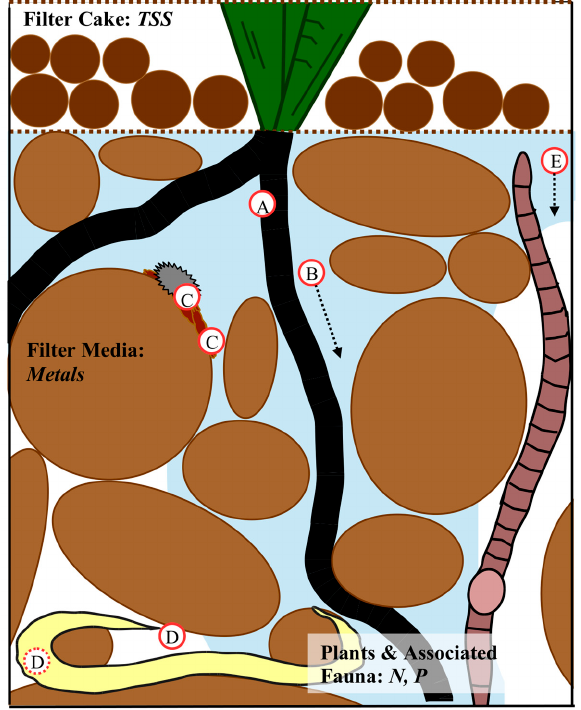
Figure 3. Microscopic cartoon of a typical biofilter filter media showing the filter cake, media grains, pore water, plant roots, and infauna (figure not drawn to scale). Fecal indicator bacteria FIB (white circle, red border), and processes relevant to FlB removal are denoted by letters A–E: ( A ) shows FIB capture via adsorption to plant roots; ( B ) shows transport in a preferential flow path alongside plant roots; ( C ) shows grazing by protozoa; ( D ) shows physicochemical attachment to filter media grains (solid red border) and subsequent ingestion by nematodes (dashed red border); and ( E ) shows transport in a preferential flow path made by a burrowing earthworm. Dominant biofilter features pertinent to the removal of other pollutants are denoted in plain text (e.g., filter cake: total suspended solids (TSS), filter media: metals, or plants and associated fauna: nutrients).